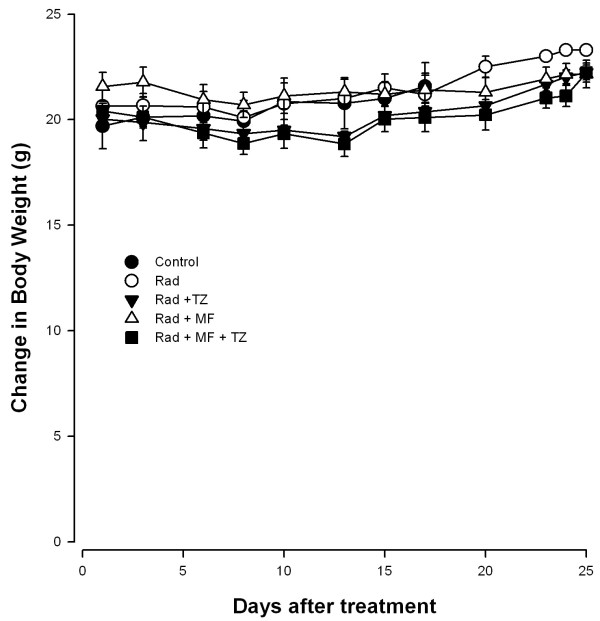
Evaluation of body weight change. Mice treated with radiation alone (○), radiation combined with Mifepristone (Δ) or Temozolamide (▼), or radiation with the combination of both (■). Controls (●) were treated only with vehicle. There was no significant difference between groups. Data are presented as the means ± SEM of four or five animals.